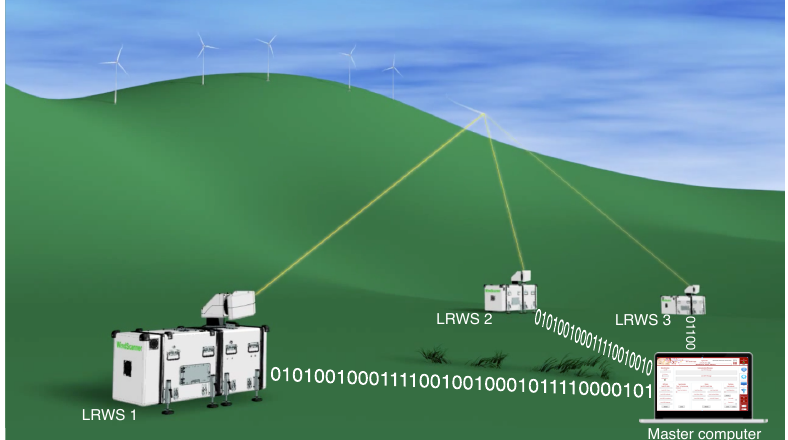
Figure 5. The long-range WindScanner system